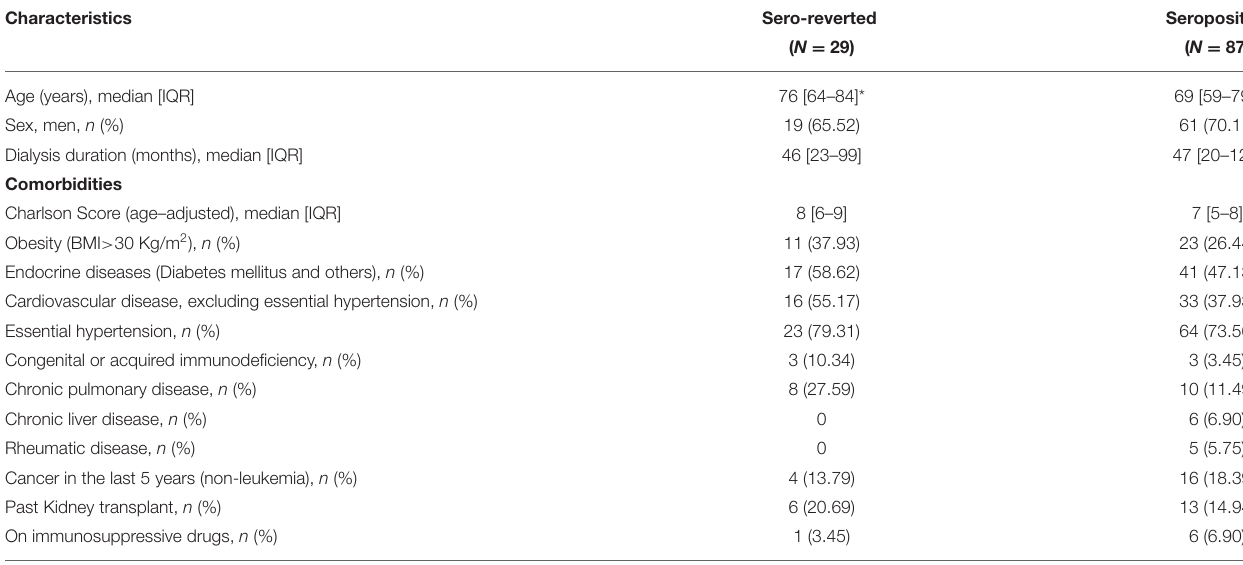
TABLE 2 | Clinical characterization of nonresponders, responders who lost (seroreverted), and responders who maintained (seropositive) anti-spike IgG at t4.